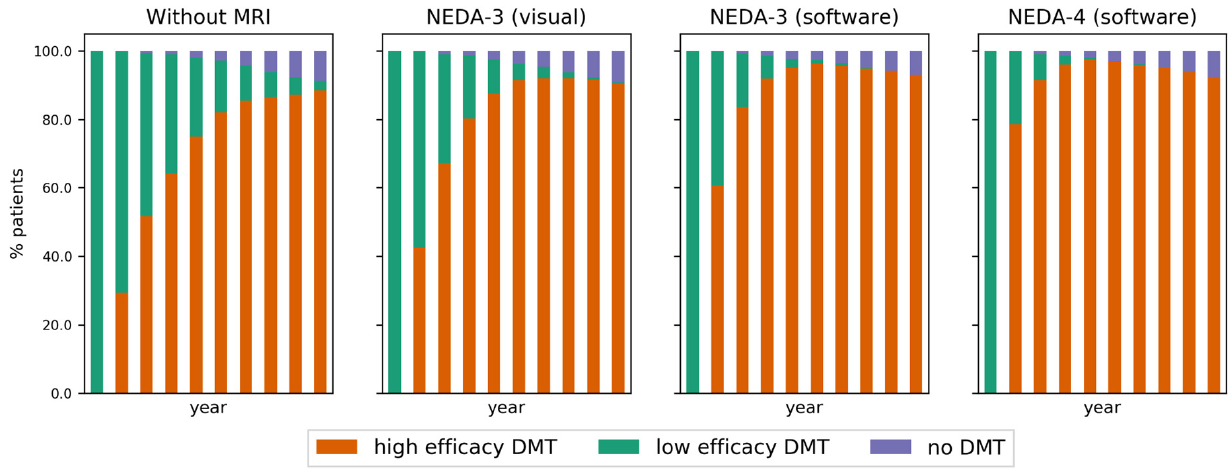
Figure 5. The proportion of patients for each strategy and cycle according to the family of DMT used. Patients who reached EDSS 7 are no longer on DMT.